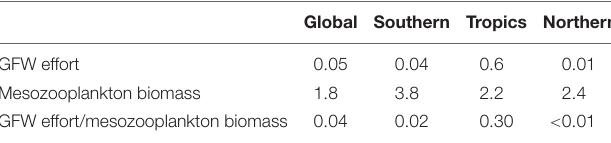
TABLE 1 | Comparison of fishing effort and mesozooplankton biomass in HNLC vs. non-HNLC regions of the open ocean. Global Southern Tropics